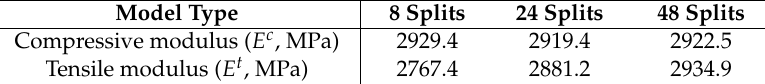
Table 2. Compressive and tensile elastic moduli obtained by the discontinuously bonded